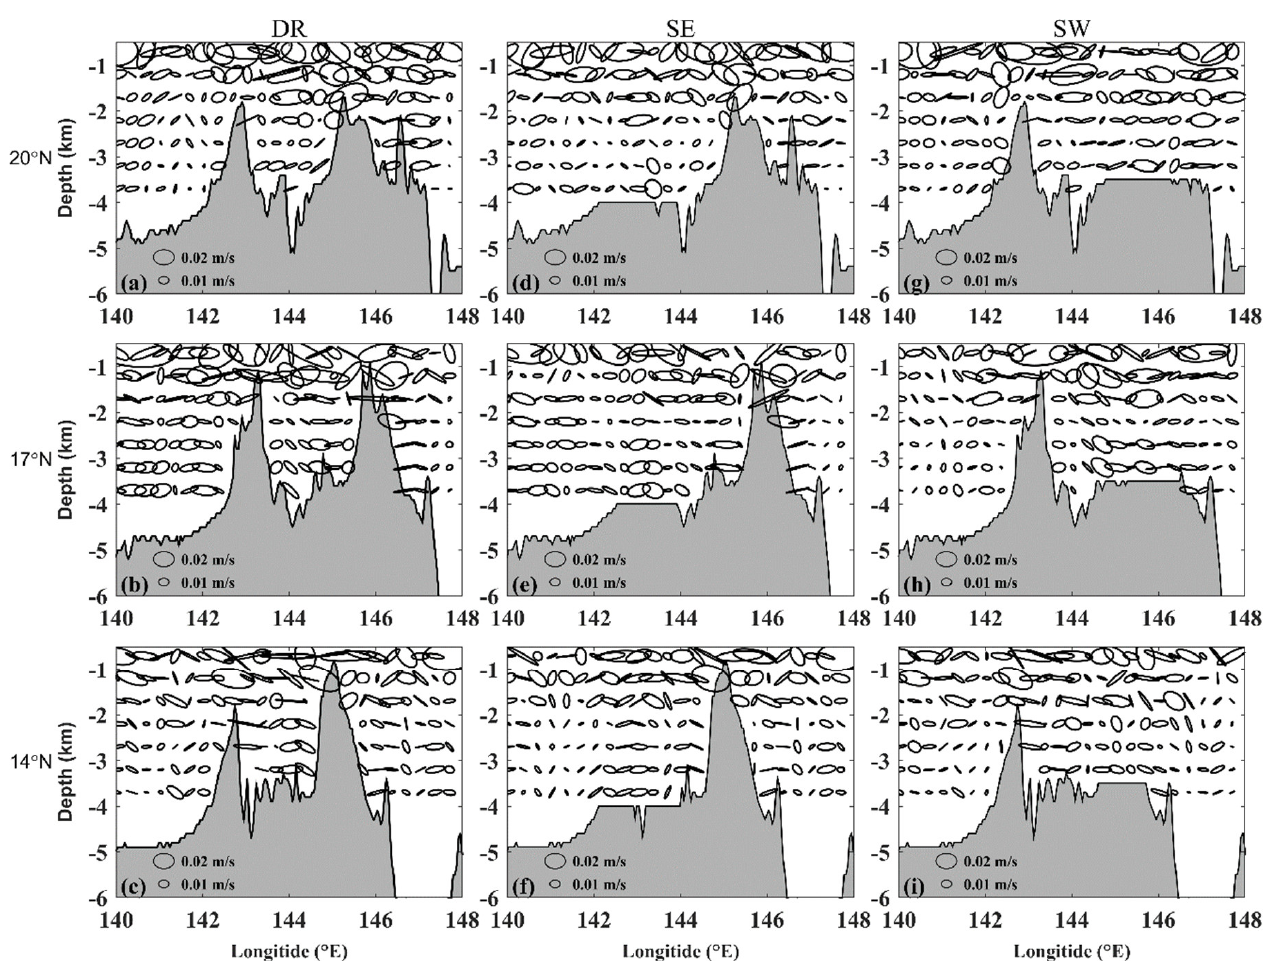
Figure 4. Vertical distributions of M 2 baroclinic tidal ellipse (m/s) along three zonal sections under ( a – c ) for DR case, ( d – f ) for SE case, and ( g – i ) for SW case. Gray shaded areas represent topography along the sections.